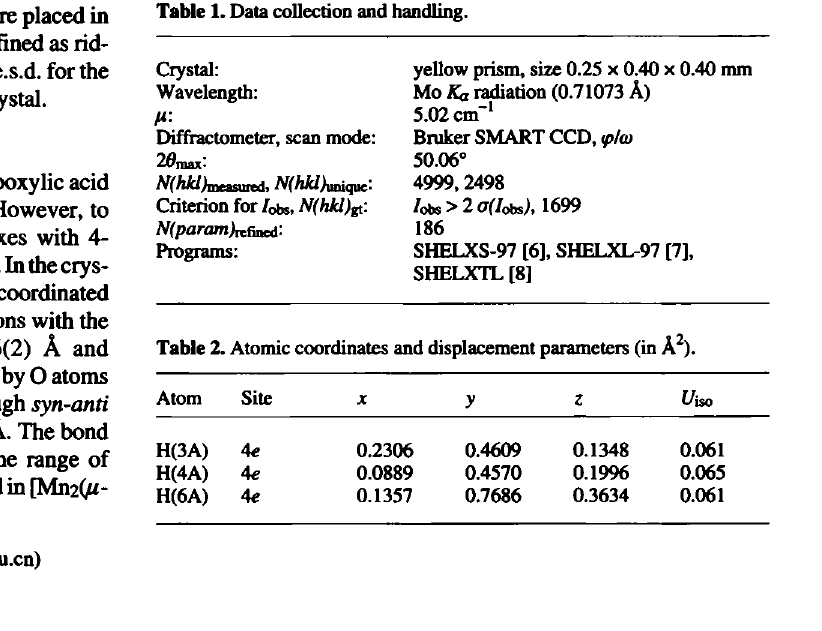
Table 1. Data collection and handling.